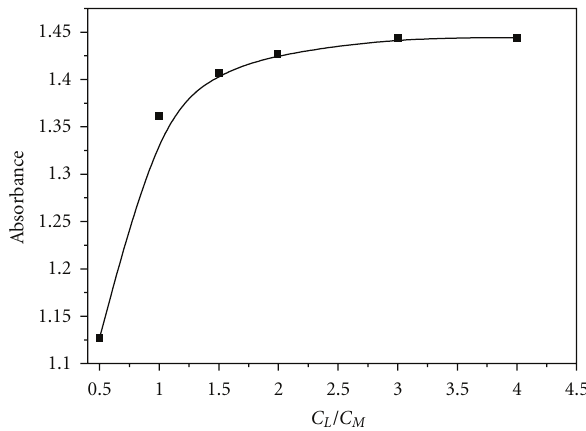
Figure 2: Variation of the absorbance at 272nm of Fe(III)-Cit as a function of the ratio C L /C M , [Fe(III)] = 0.3 mM, pH = 6.1.